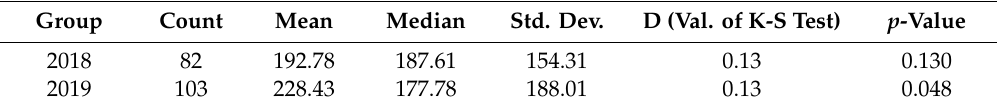
Table 9. The results of the Kolmogorov-Smirnov test of normality for test results in group 2018 and group